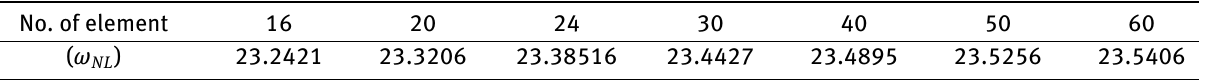
Table 2: Convergence study of nonlinear fundamental frequency for UD distributed CNTRC beam with V * cn = 0.28 , W max / h = 1.0 , and a / h = 25 .